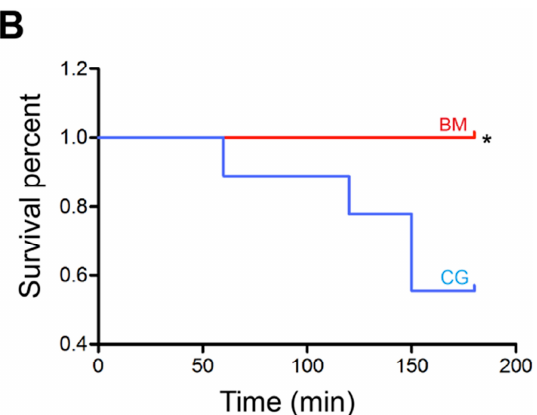
Figure 1. Mean arterial pressure (MAP) and survival rate. ( A ) The mean MAP for each swine group (surviving and non-surviving). The MAP of BloodSTOP iX Battle Matrix (BM)-treated animals significantly increased compared to that of QuikClot Combat Gauze (CG)-treated animals in response to resuscitation at 75, 90, and 135–180 min (* p < 0.05) post-treatment; ( B ) Log-rank (Mantel–Cox) analysis of survival time of swine treated with each dressing. The BM-treated swine lived significantly longer compared to CG-treated swine (* p < 0.05).